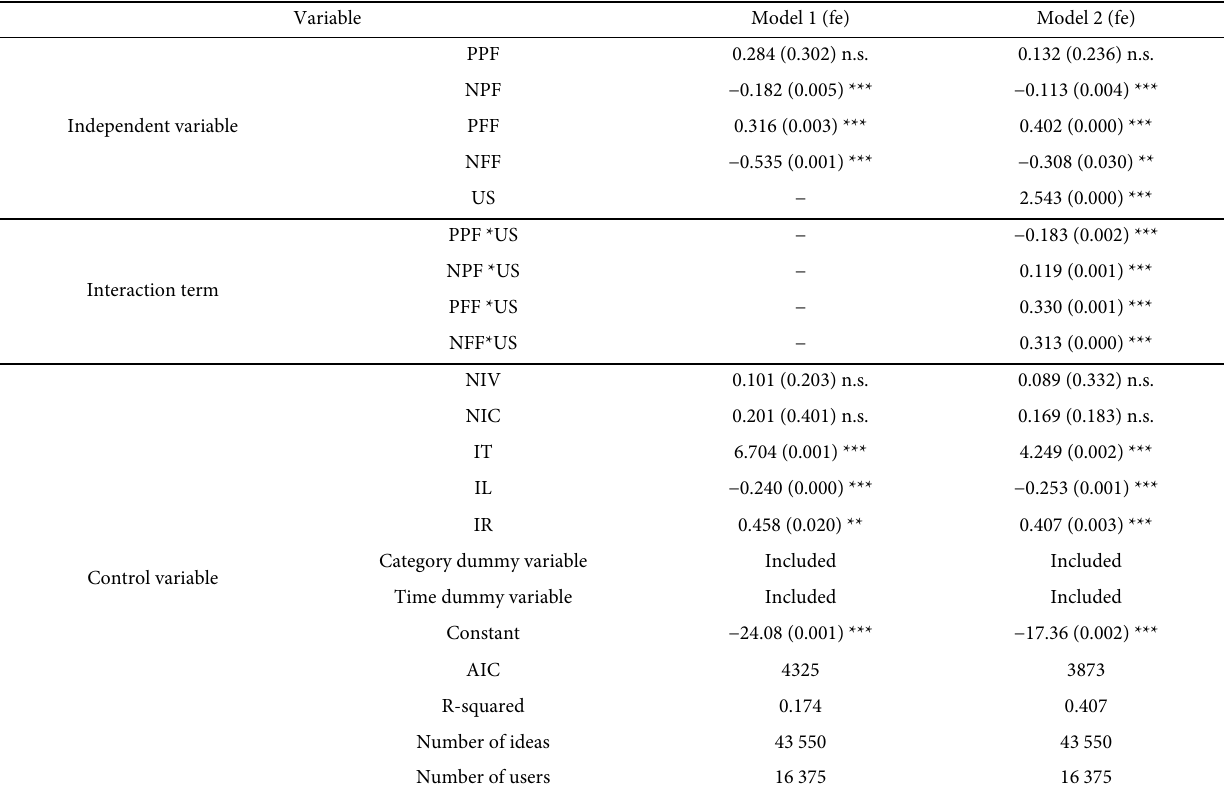
Table 5 Estimation